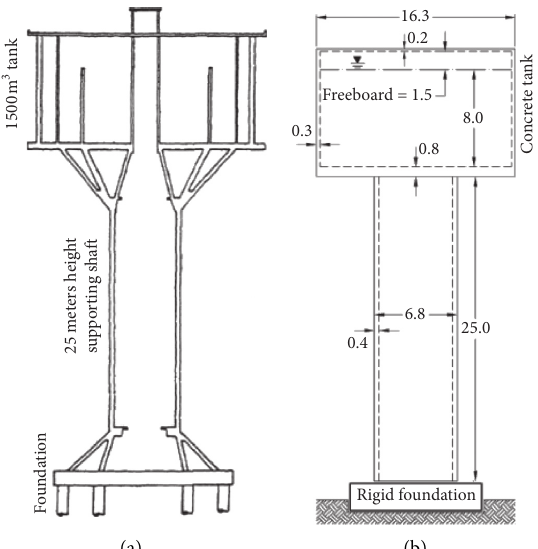
Figure 8: (a) Schematic section of water tower No. 1 located in Rasht, north of Iran, which collapsed during Manjil, 1990, earthquake, and (b) dimensions of the simplified concrete